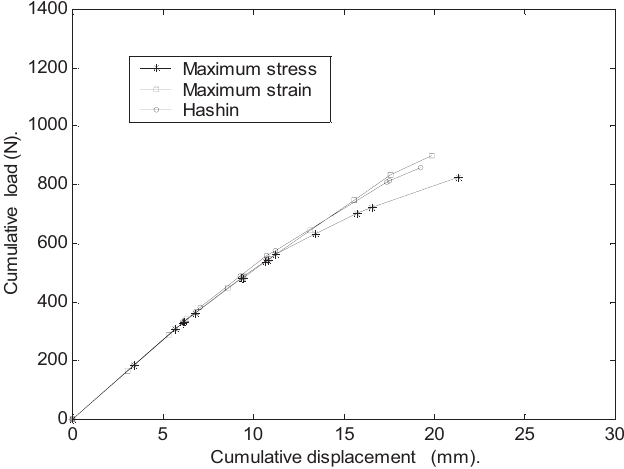
Fig. 4. Cumulative macroscopic curves of the test sample E with the limited discount method (matrix stiffness